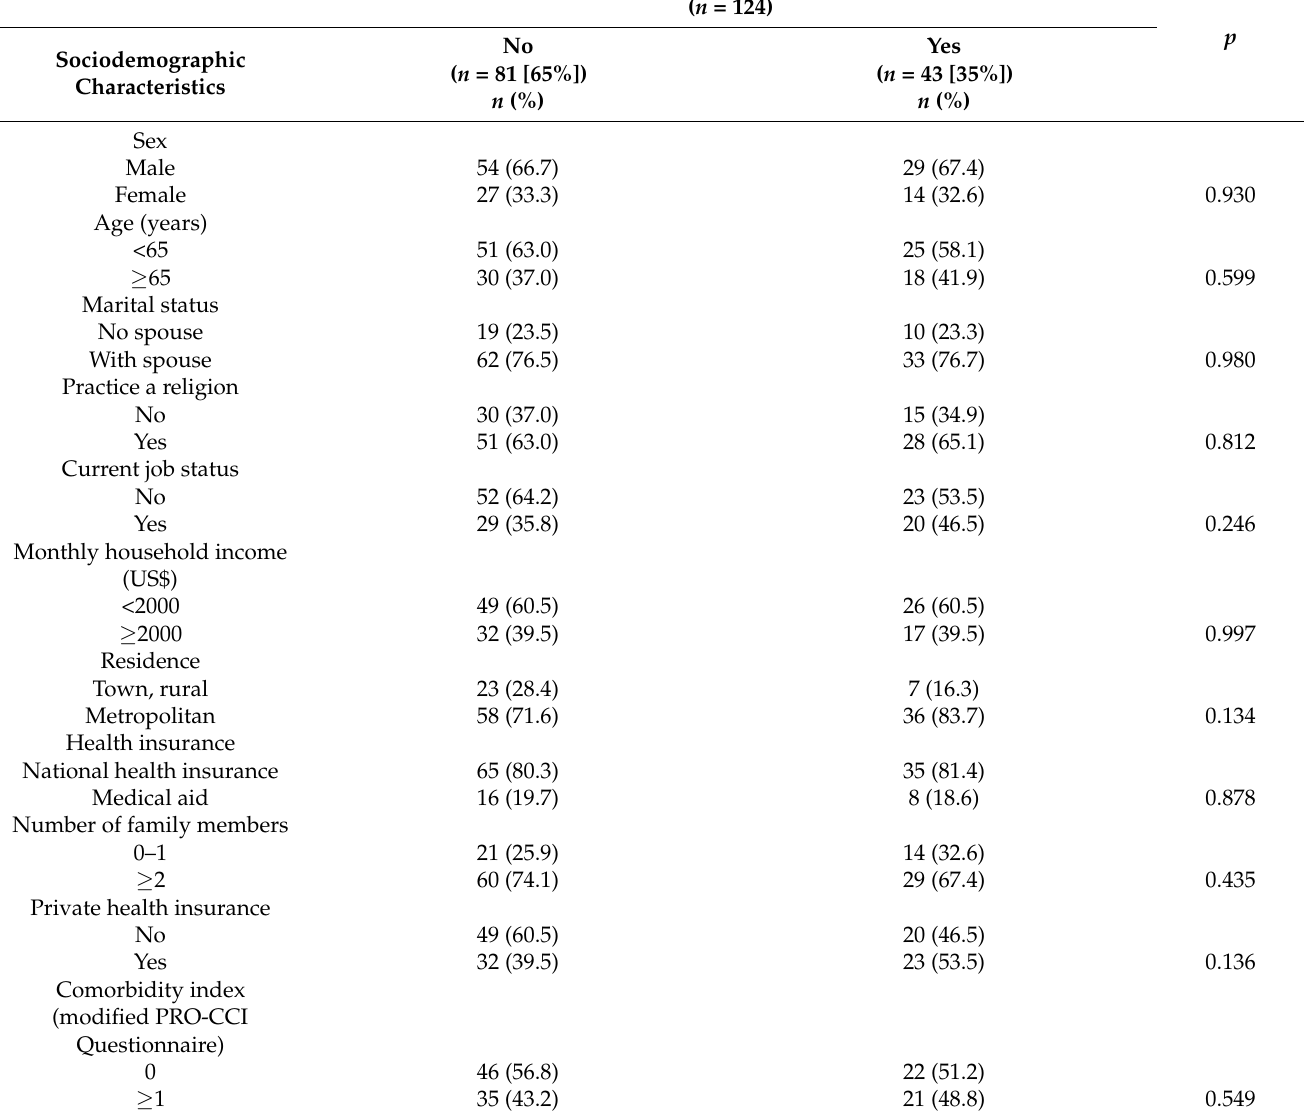
Table 2. Univariate analyses: association between sociodemographic characteristics and performing exercise. Aerobic Exercise with Moderate Intensity at Least 150 min/wk for at Least 6 Months